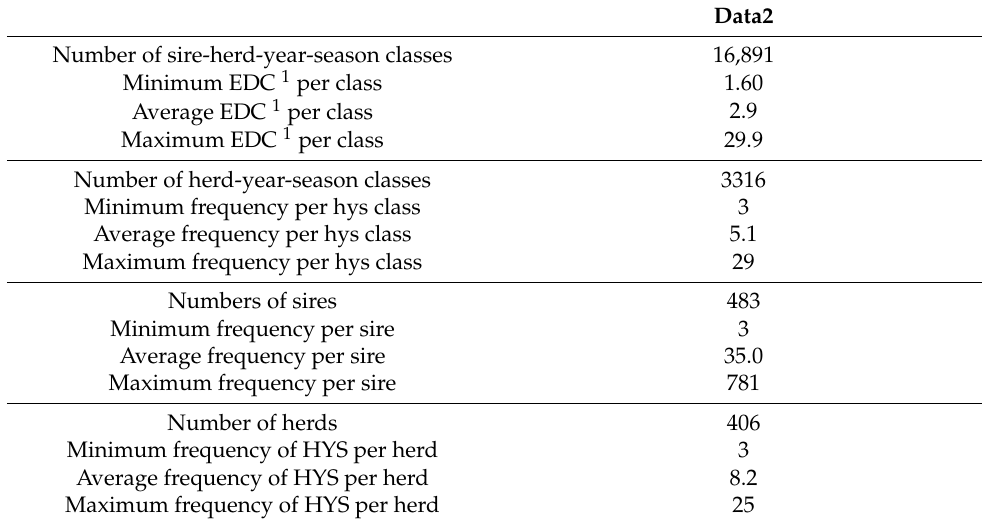
Table 2. Descriptive statistics for the datasets including herd-year-season